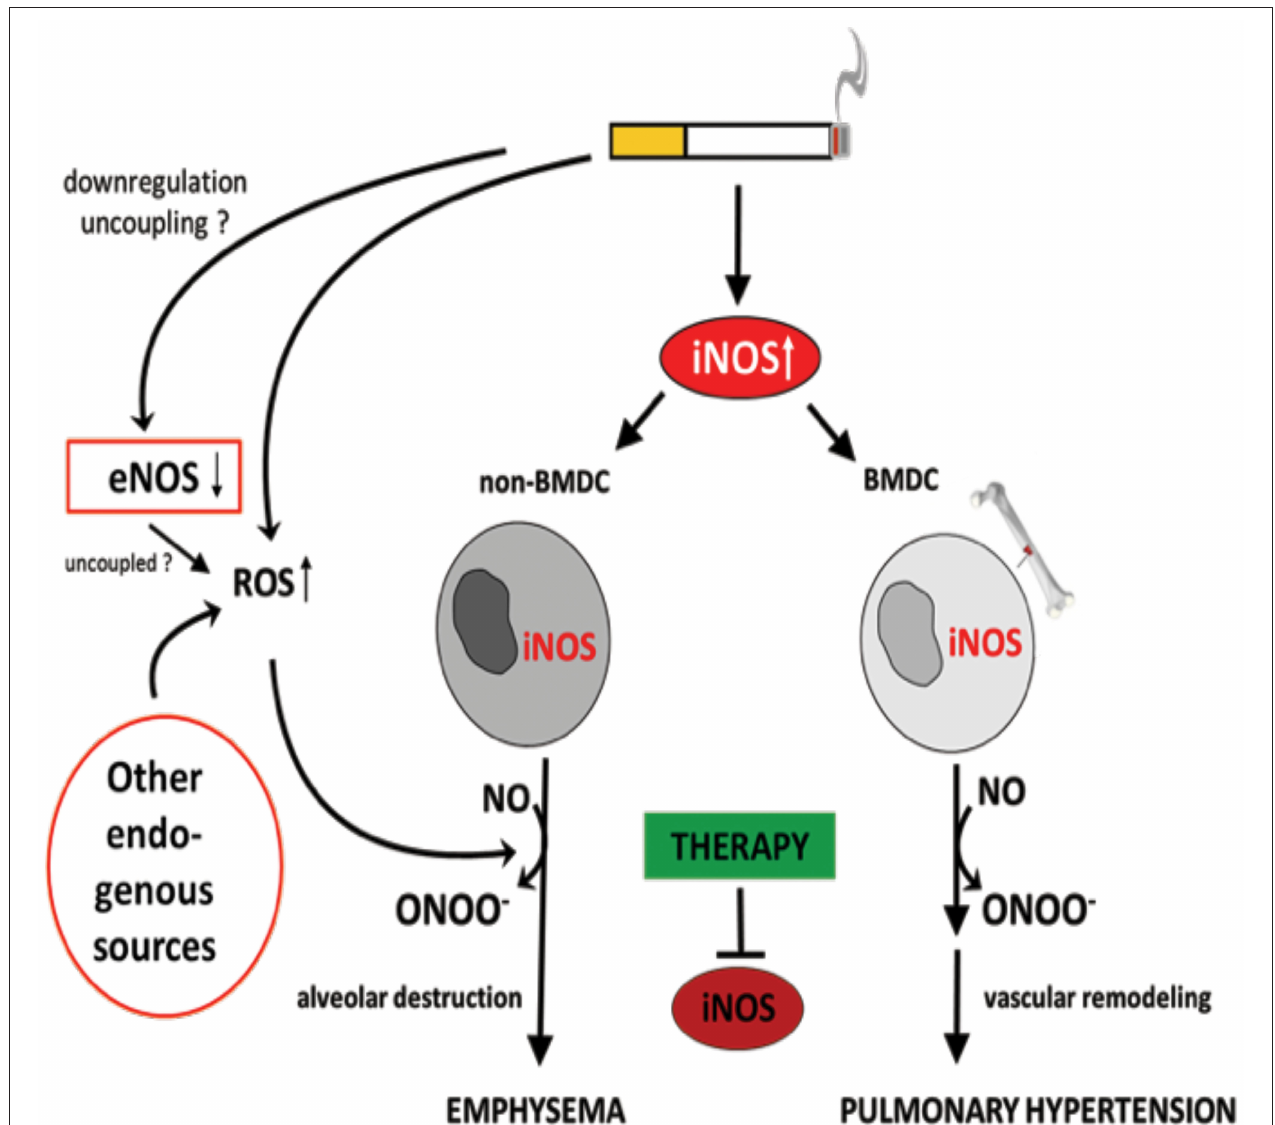
FIGURE 5 | Identification of inducible NO synthase (iNOS) as an essential factor for the development of cigarette smoke-induced emphysema and pulmonary hypertension in mice. Cigarette smoke-mediated upregulation of iNOS leads to excessive NO production. The formation of peroxynitrite, resulting from the reaction of NO with superoxide, was suggested to mediate emphysema and PH development. Superoxide can derive from cigarette smoke itself and/or from uncoupled eNOS, NADPH oxidases, xanthine oxidases, cyclo- and lipooxidases, and mitochondria. Of interest, iNOS generated by non-bone marrow-derived cells (N-BMDC), possibly vascular cells, leading to lung destruction resulting in emphysema whereas elevated iNOS expression in bone marrow-derived cells (BMDC) causes vascular remodeling. Treatment with specific iNOS inhibitor L-NIL prevents or even reverses pathological